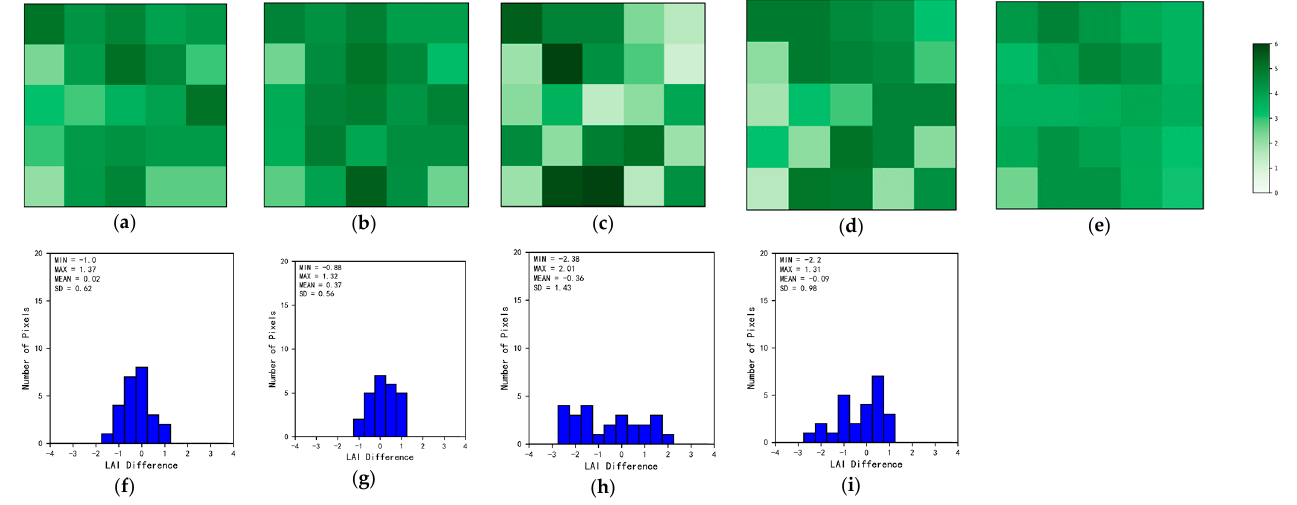
Figure 6. Images of the LAI-TCA ( a ), the LAI-GRNN ( b ), the VIIRS ( c ), the MODIS ( d ) and the LAI values acquired from high-resolution reference maps ( e ) at the Collelongo site on Day 268, 2015. ( f – i ) Statistical distributions of discrepancies between the LAI-TCA, the LAI-GRNN, the VIIRS, the MODIS and the LAI values acquired from high-resolution reference maps.